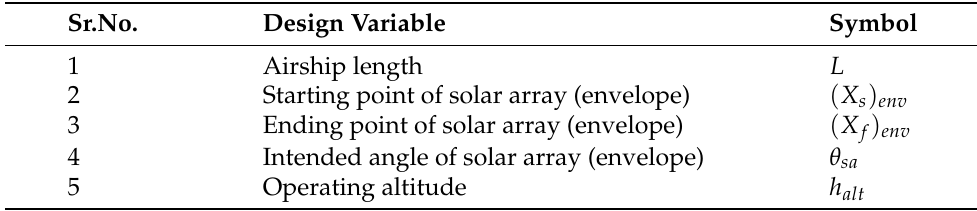
Table 4. Condensed list of design variables—conventional configuration.